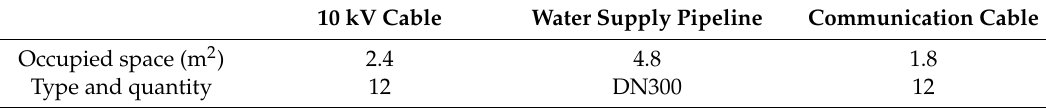
Figure 9. Cross-sectional view of the Yincounty Avenue utility tunnel. Table 5. Engineering parameters of pipelines laid in the Yincounty Avenue utility tunnel.